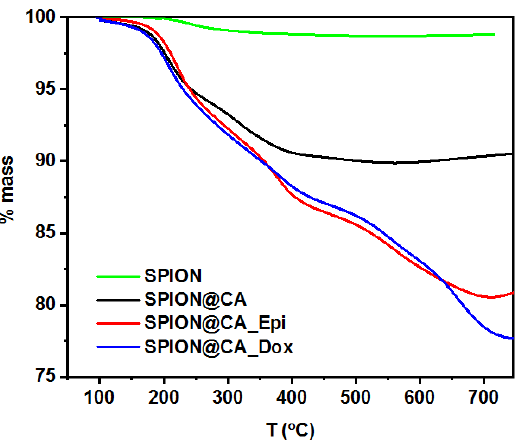
Figure 5. Thermograms of the SPION, SPION@CA, SPION@CA_Dox, and SPION@CA_Epi. It turns out that the content of the drug is 11 ± 1.0 % and 9 ± 0.9%, for doxorubicin and